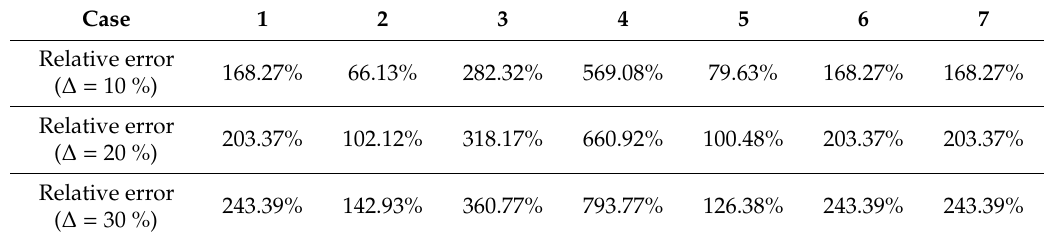
Table 3. Inversion error of chlorophyll with single-wavelength lidar under Cases 1–7 and di ff erent ∆